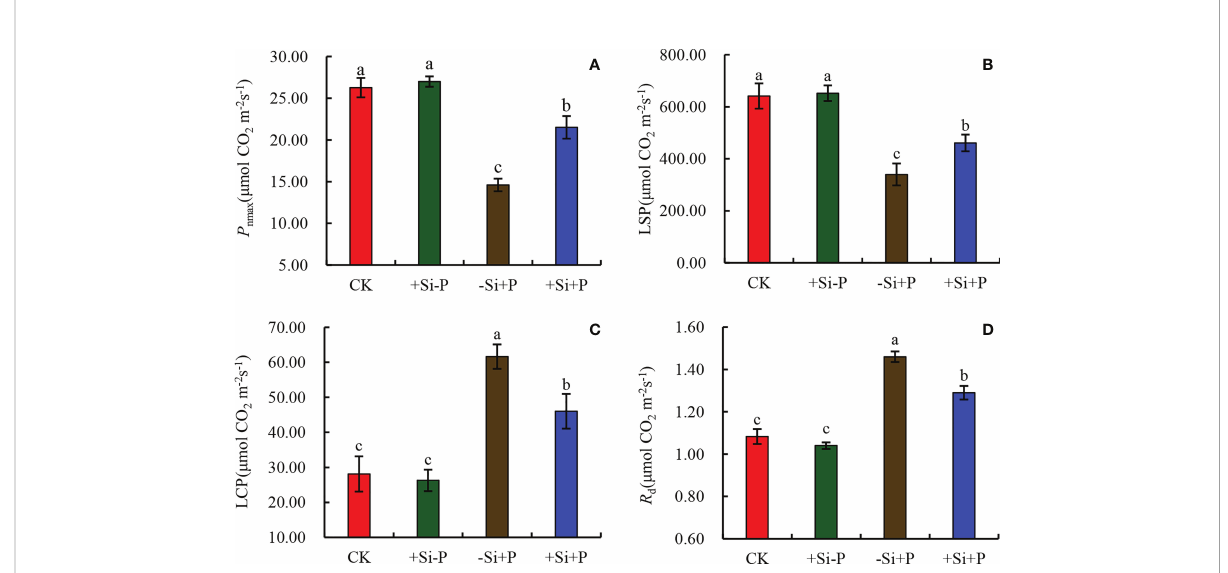
FIGURE 4 Effects of Si application and Pga inoculation on light response parameters of oat leaves. (A) , maximum photosynthetic rate ( P nmax ); (B) , light saturation point (LSP); (C) , light compensation point (LCP); (D) , dark respiration rate (Rd). CK, no Si application and no Pga inoculation; +Si-P, 1.5 mmol·L – 1 Si application and no Pga inoculation; -Si+P, no Si application and Pga inoculation; +Si+P, 1.5 mmol·L – 1 Si application and Pga inoculation. Data are expressed as mean ± SE (n=3). According to Duncan ’ s multiple comparison tests among treatments, different letters on bars show signi fi cant differences at 0.05 level of probability.